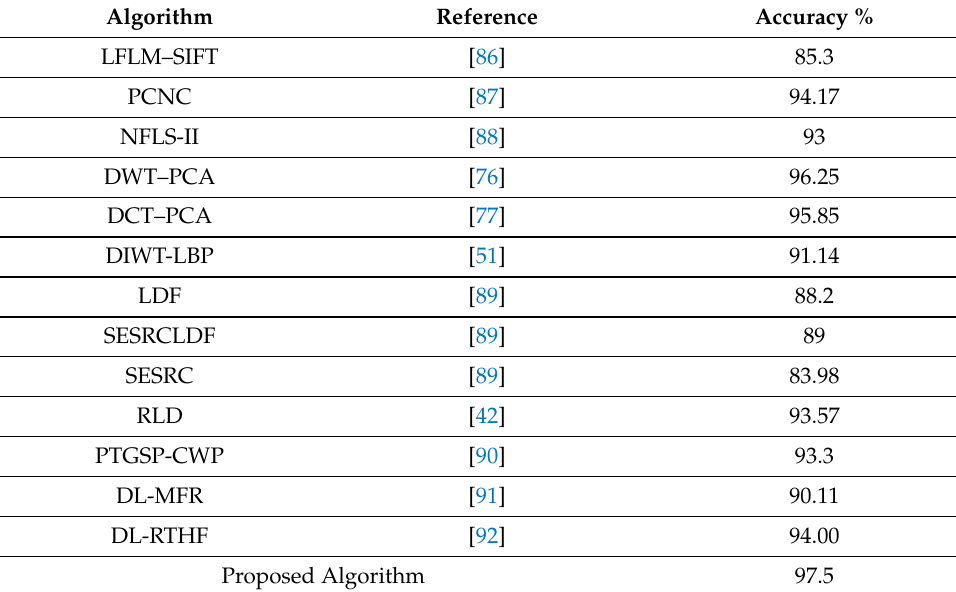
Table 7. Comparison with existing algorithms on FEI